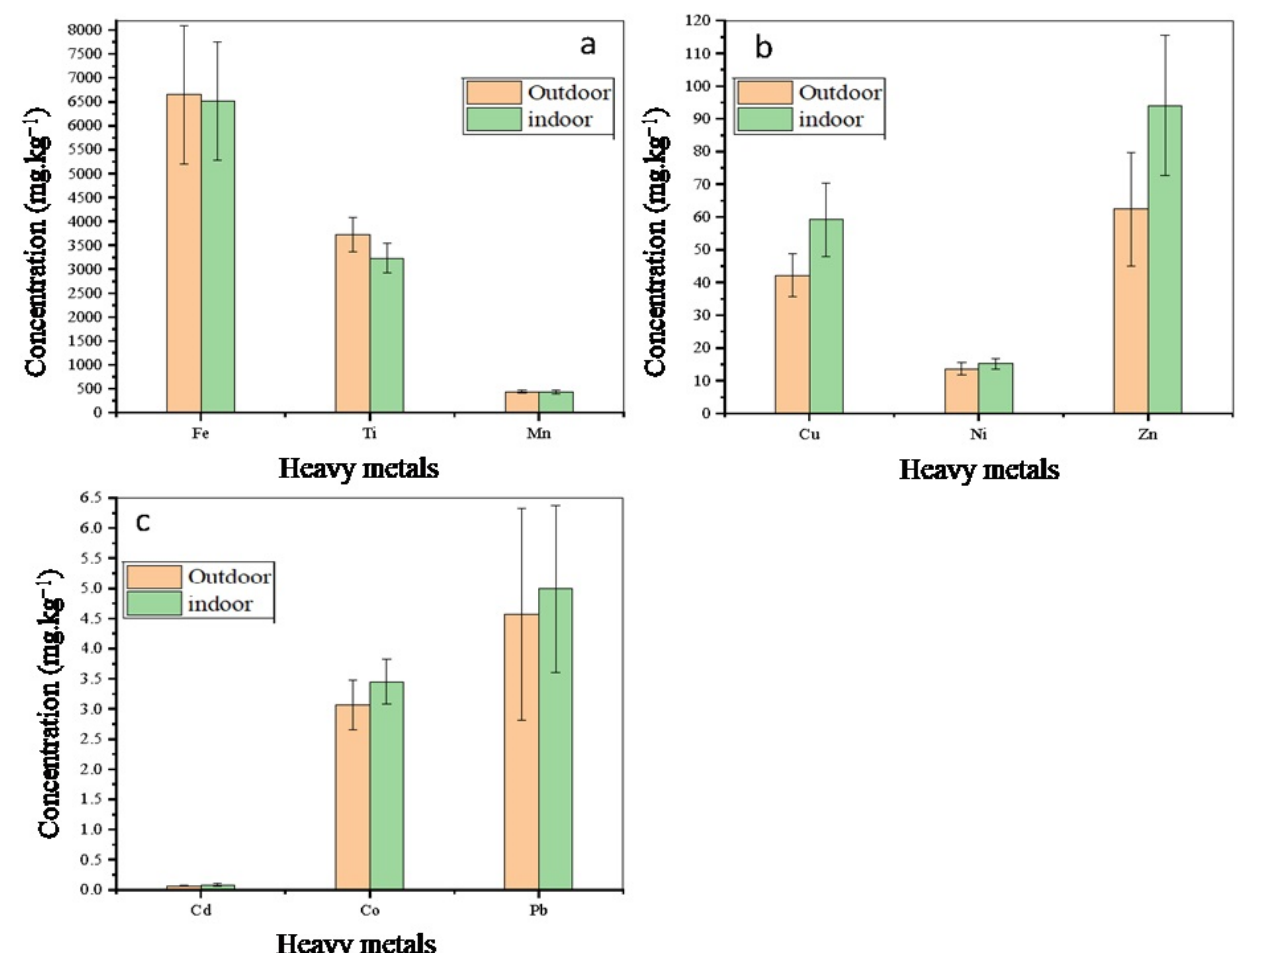
Figure 2. The mean concentrations of heavy metals ( a ) Fe, Ti, and Mn; ( b ) Cu, Ni, and Zn; ( c ) Cd, Co, and Pb) in the outdoor and indoor dust in school environment.